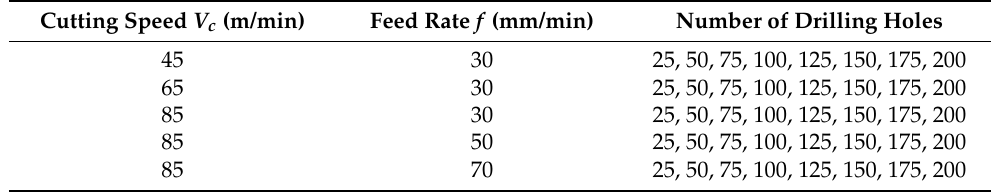
Table 2. Single factor experimental scheme of tool wear.